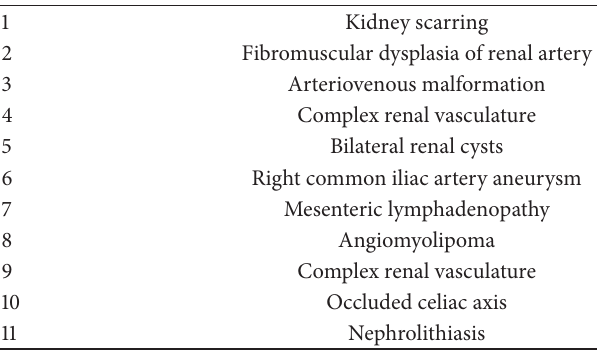
Table 1: Unfavorable findings on CT renal